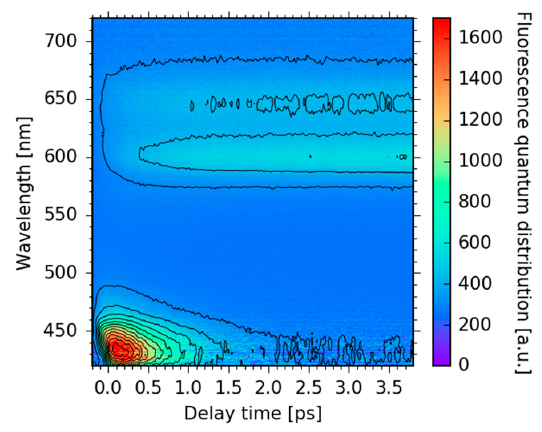
Figure 2. Fluorescence map of Sb-tpfc-F 2 upon excitation at 400 nm. The fluorescence wavelength in nm is plotted as a function of delay time in ps. Fluorescence quantum distributions are color coded.